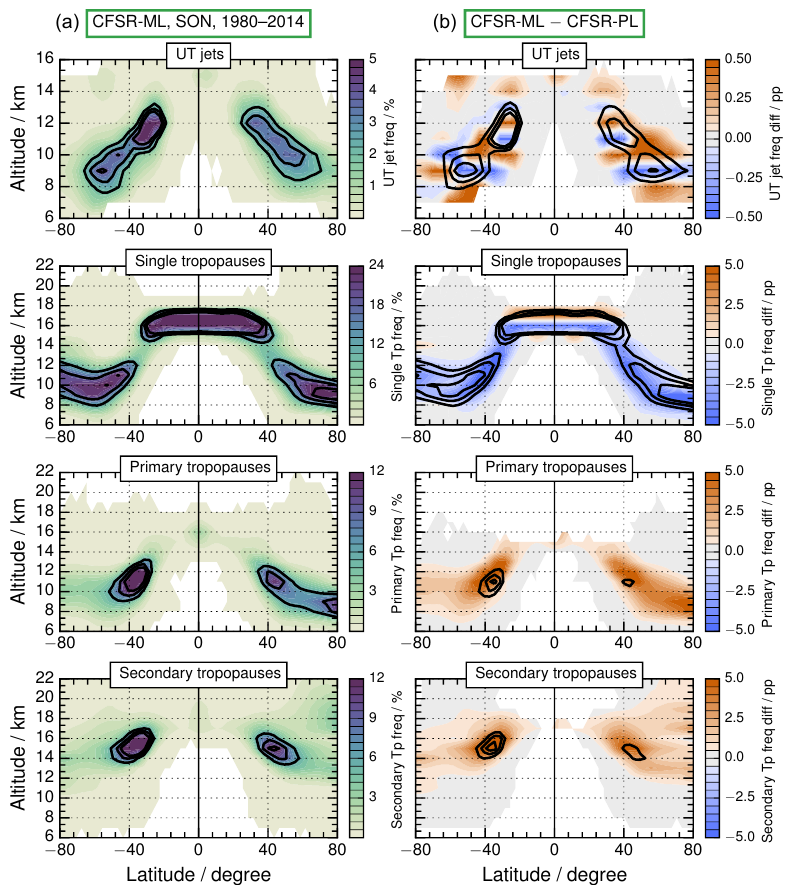
Figure 4. Seasonal cross sections for SON in 1980 through 2014 of CFSR frequency distributions from model-level data (a) and the difference between model and pressure-level data (b) . Layout is as in Fig.